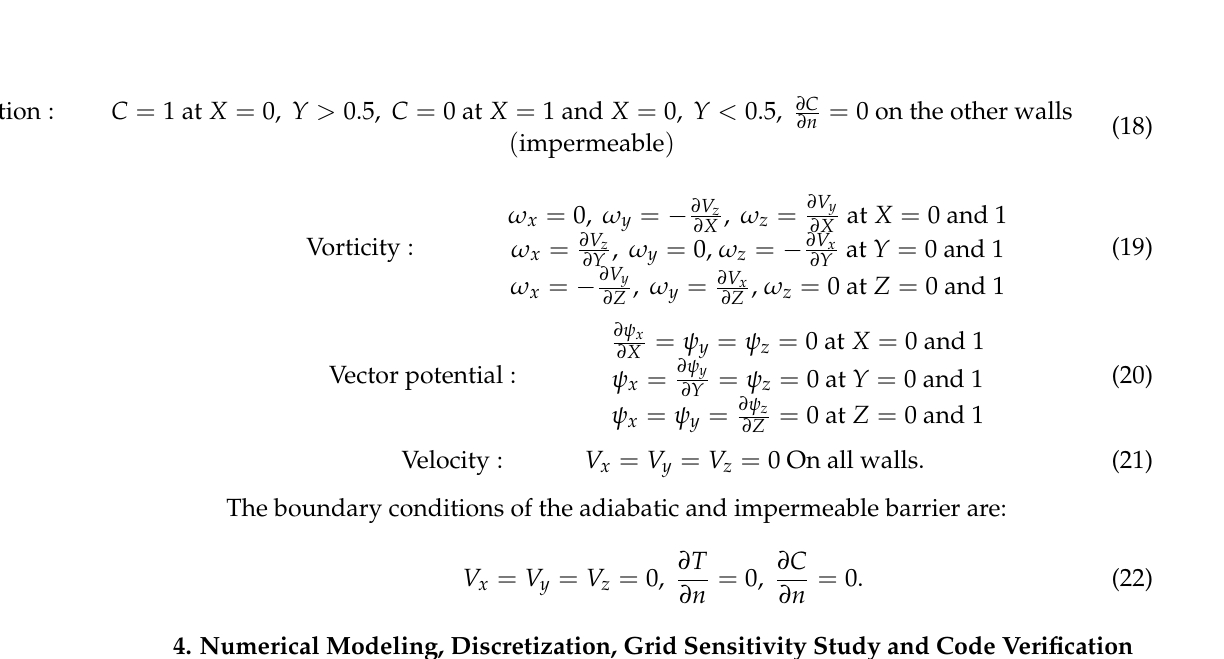
Table 1. Overview of the dimensionless equations.